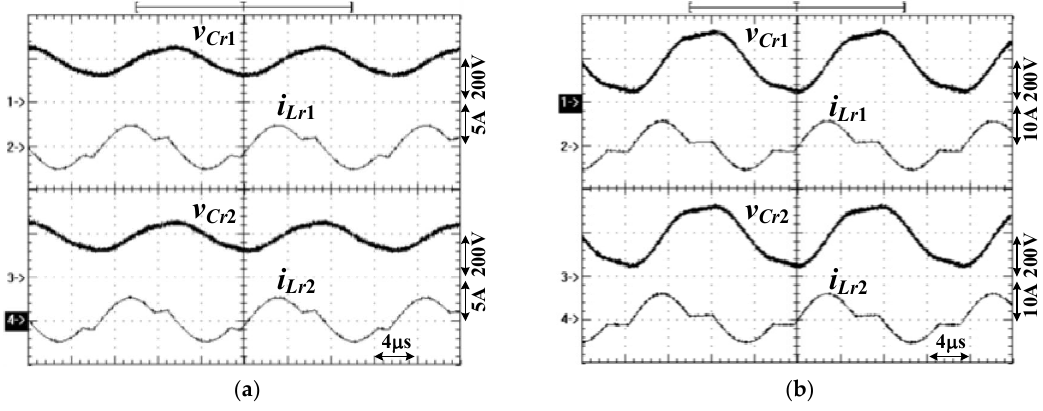
Figure 9. Experimental waveforms of V C 1 , V C 2 , and V Cf ( a ) at 50% power and ( b ) rated power.